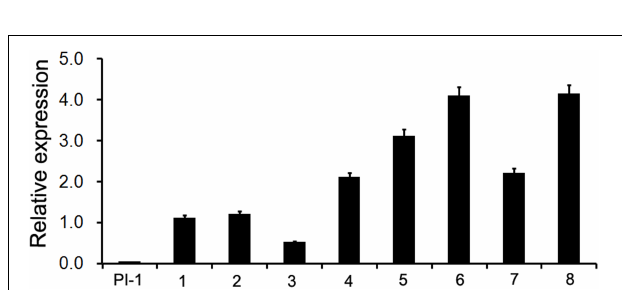
FIGURE 6 | Quantitative Real-time PCR analysis of the MAwuPI transcript levels in complementary lines. At least three biological replicates and three technical replicates were performed for each data. Gene expression level was shown as fold changes, and the gene expression level in wild-type Arabidopsis plants was set as 1. Error bars represent standard error of the means of three biological repeats. Atactin is used as internal control. PI-1, pi-1 mutant; 1–8, different 35S::MAwuPI transgenic lines in Arabidopsis pi-1 mutant